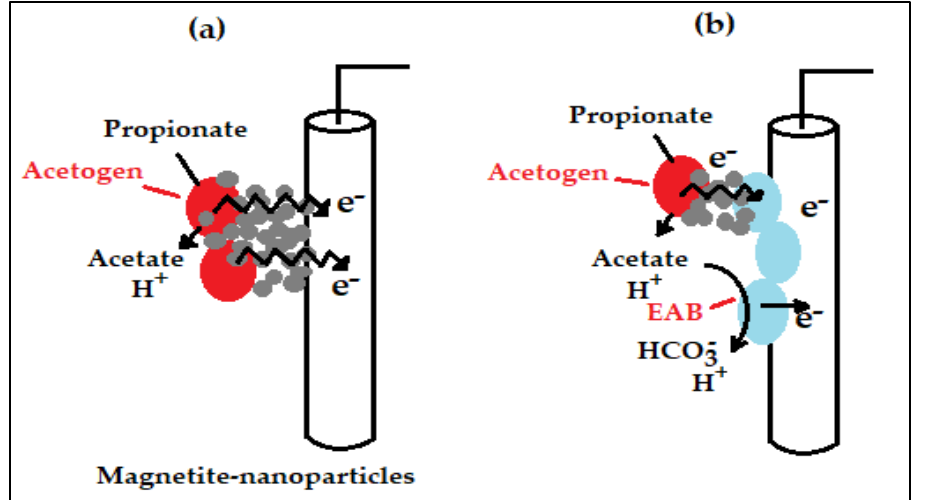
Figure 11. Proposed reactions supporting the influence of magnetite-nanoparticles on the degradation of propionate: ( a ) electron transfer that comes from oxidation of propionate to the electrode compartment via magnetite-nanoparticles, and ( b ) electron transfer that comes from the degradation of propionate to electrochemically-active bacteria through magnetite-nanoparticles [18].